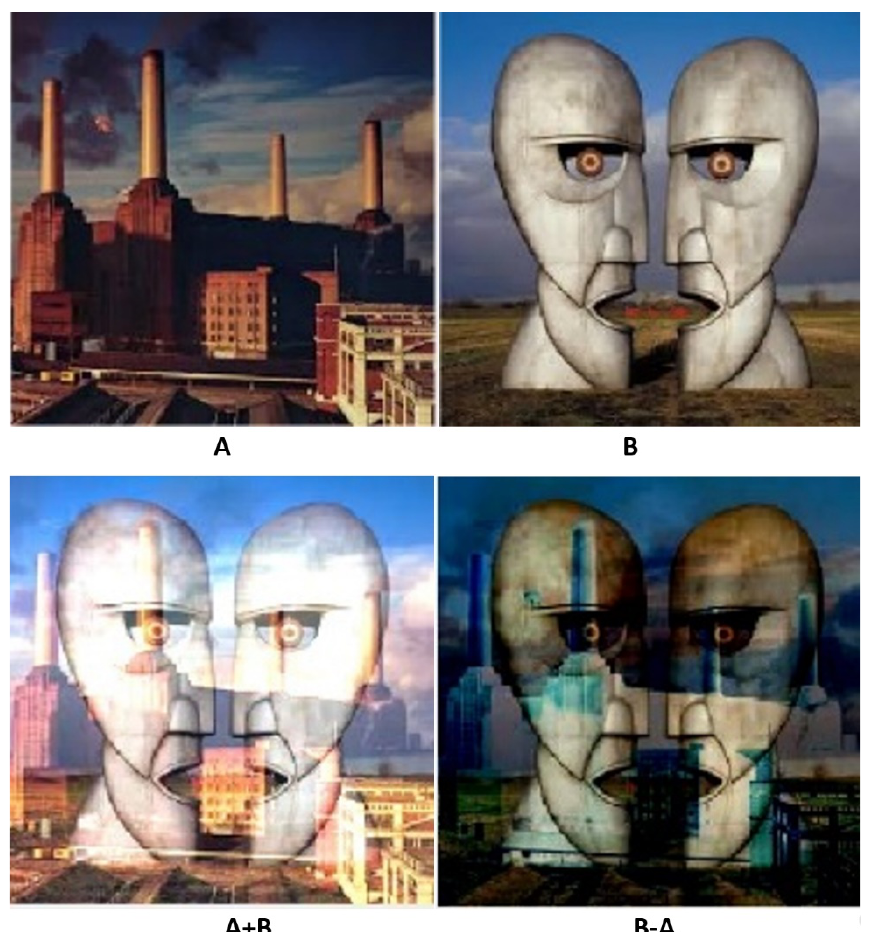
Figure 3. Some matrix operations using digital images (wikipedia.org, n.d.a, n.d.b)